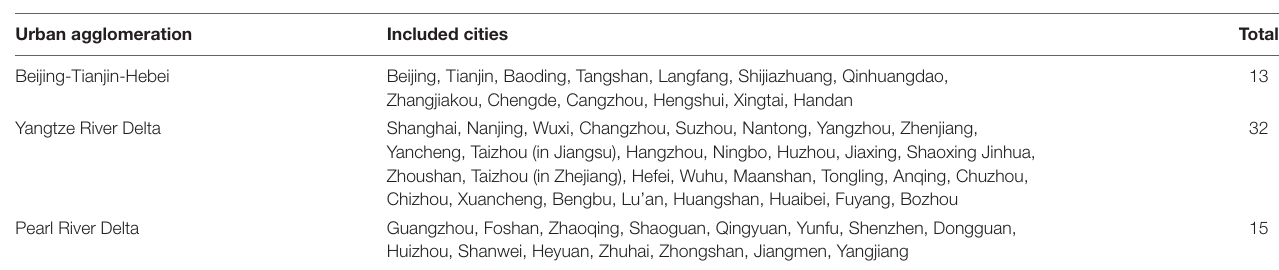
TABLE 2 | China’s three major urban agglomerations and their